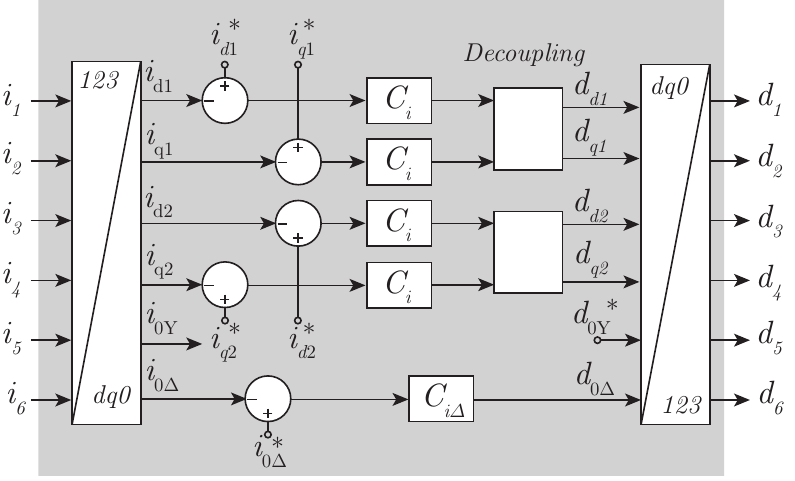
Figure 4. Current control scheme for the